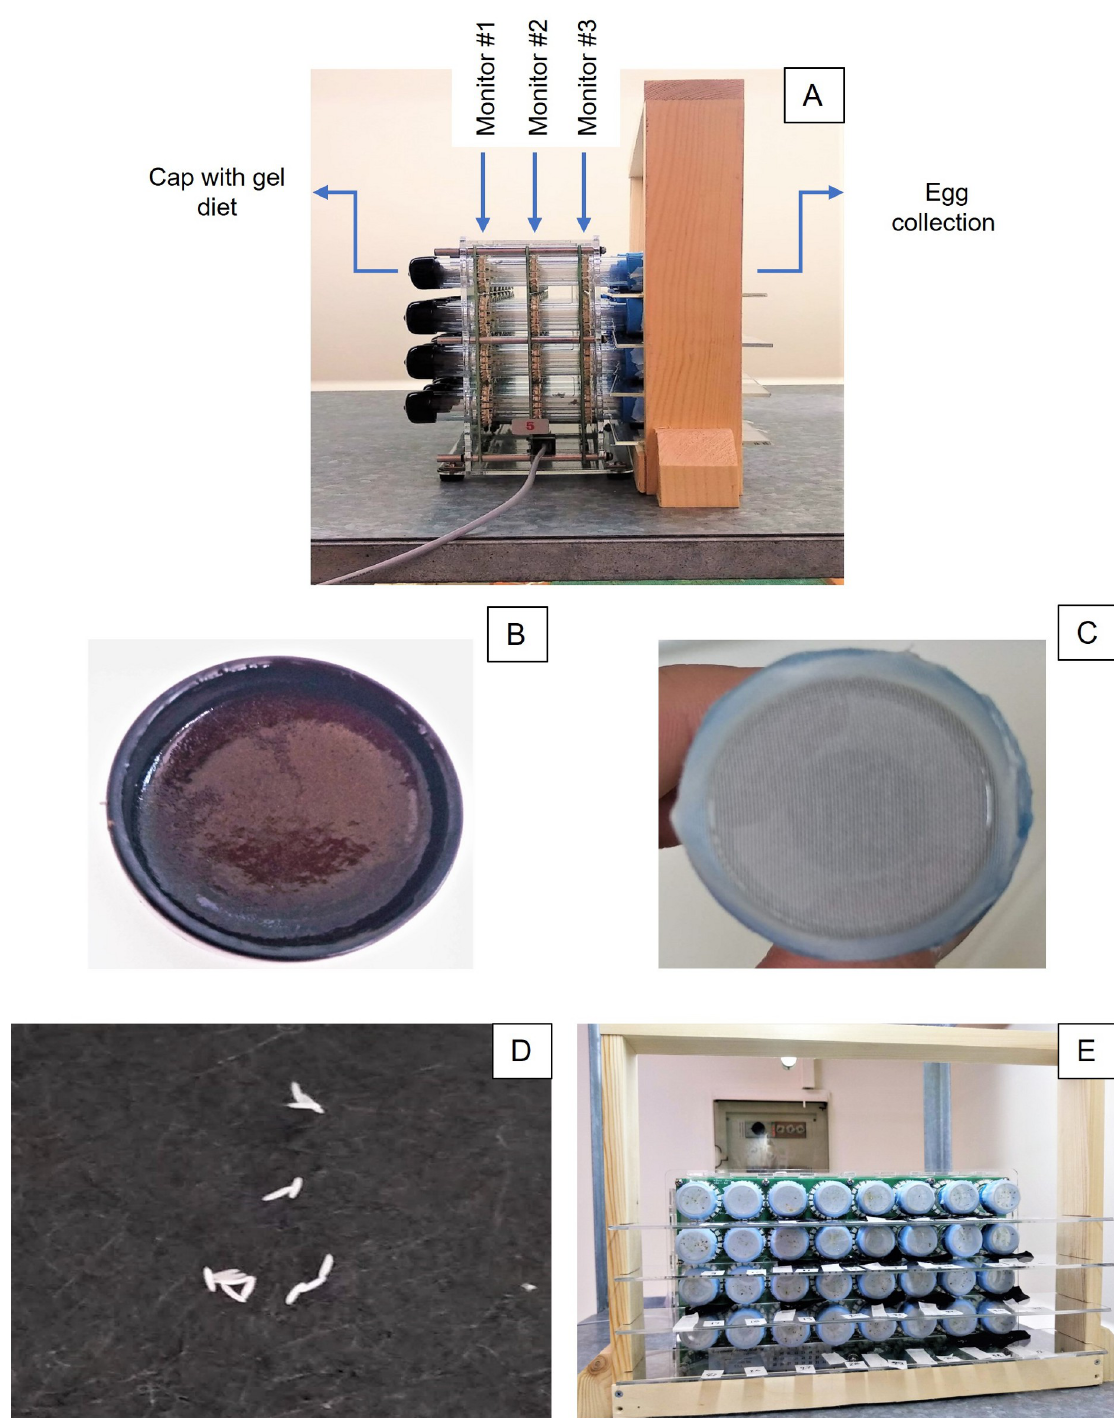
Fig 1. Side view of the LAM25system set in the laboratory (A). Vinyl plastic stopper placed on one end with the agar-based gel diet (B). Cap with organdie cloth placed on the other end for ventilation of tubes (C) and for egg deposition (D). Wooden- plastic, handmade construction, for egg collection